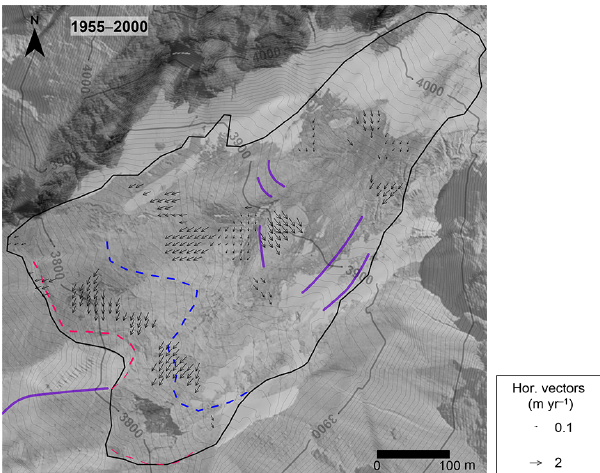
Figure 13. Horizontal displacements and elevation changes at the surface of Las Tetas between 1978 and 2000. The boundary between debris-covered and rock glacier morphology is depicted with a dot- ted red line in 1978 and with a dashed red line in 2000. Thermokarst depressions in 1978 are indicated. Thermokarst areas could not be accurately and reliably delineated on the 2000 orthophoto and are hence not mapped. The background of the map is the 2000 or- thophoto.